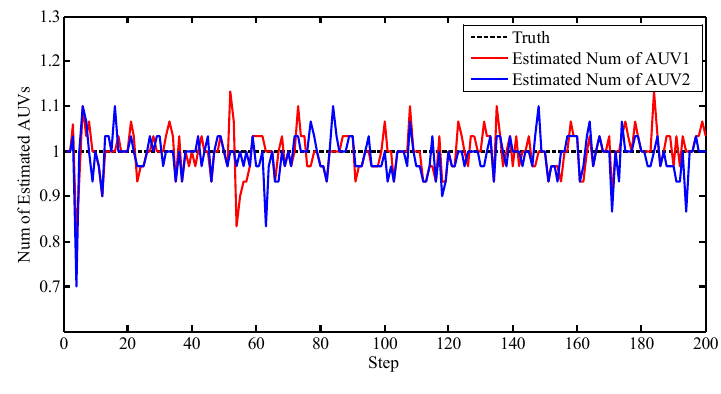
Figure 9. Number of estimations.